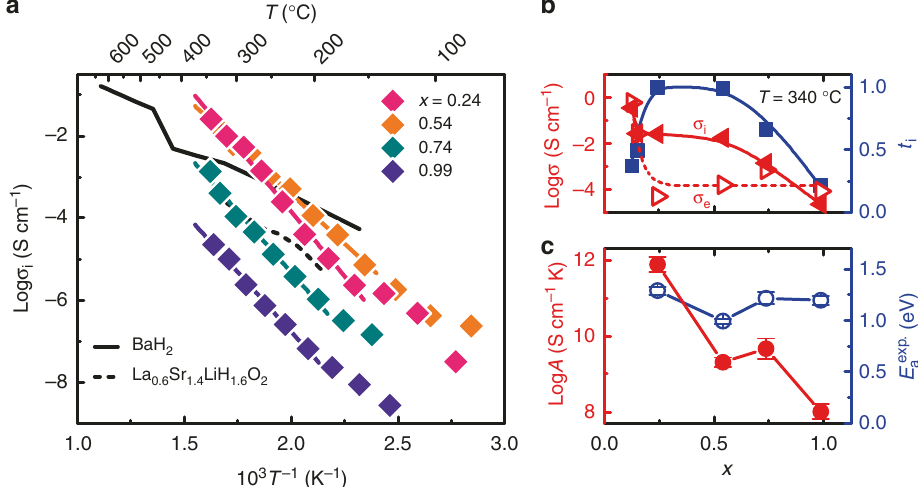
Fig. 2 Alternating current impedance spectra and direct current polarization data. a , b Complex impedance plots of sample with x = 0.24 at T = 212 °C and T = 342 °C. The corresponding equivalent circuits used for the simulation are shown in the insets. C constant phase element, and inductance, respectively. Open black circles show the result for Cu. c Current as a function of time upon application of 0.1 V constant voltage at x = 0.25 and T = 342 °C